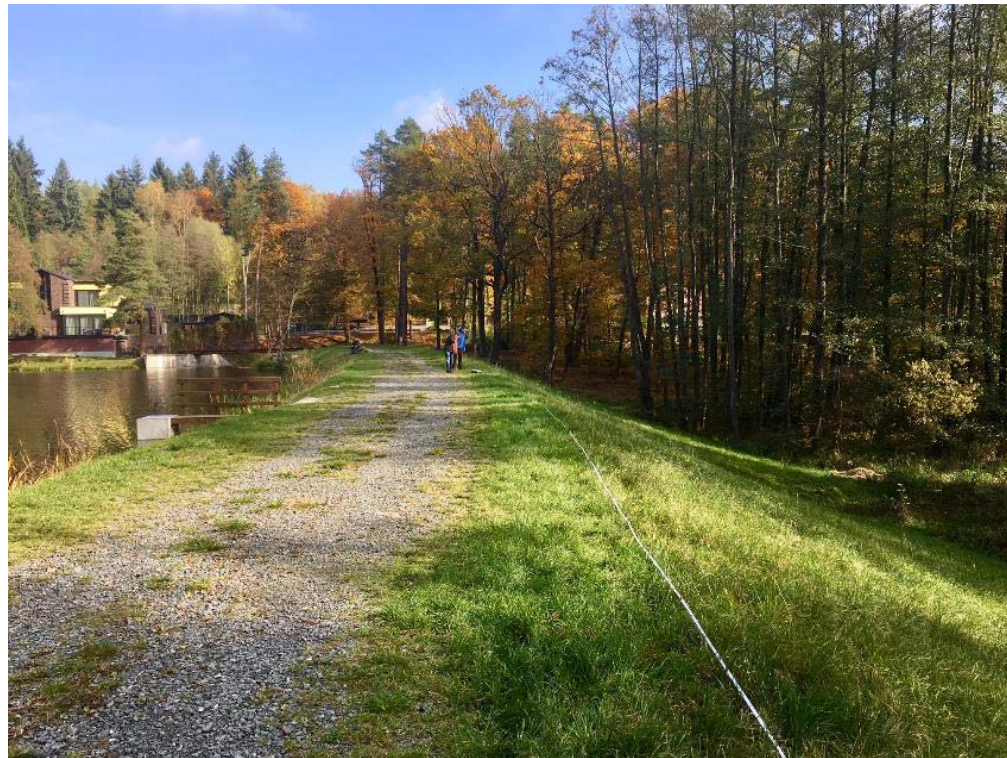
Figure 1. Dam of the fishpond Jan after the